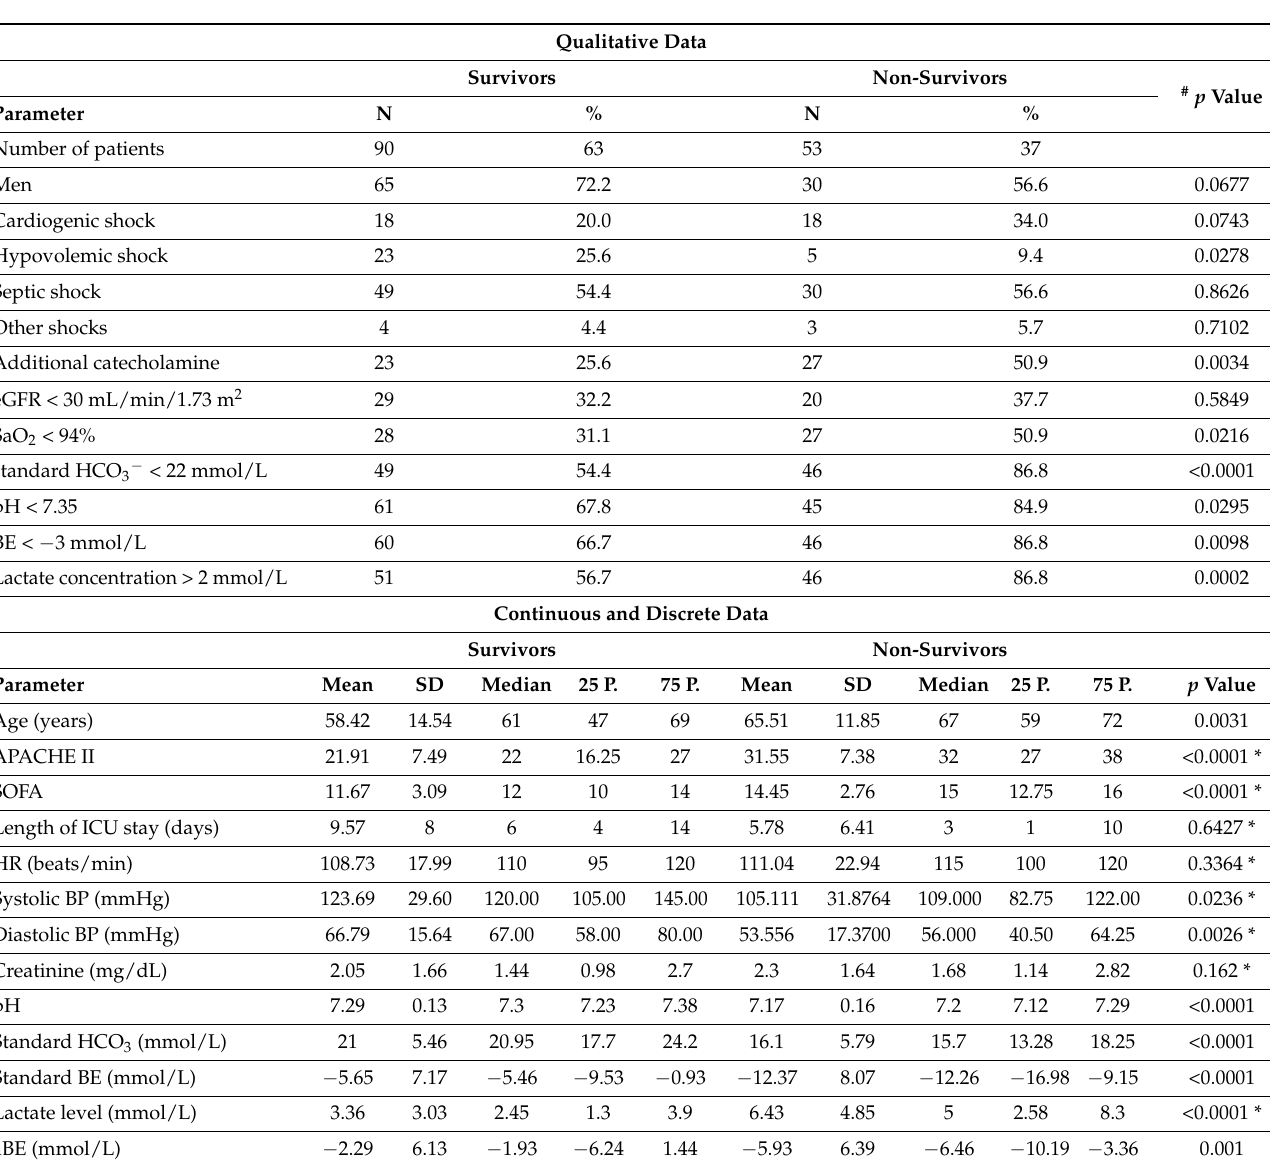
Table 1. Summary of comparisons of clinical characteristics in a group of patients with shock divided into survivors and non-survivors of the 28-day stay at